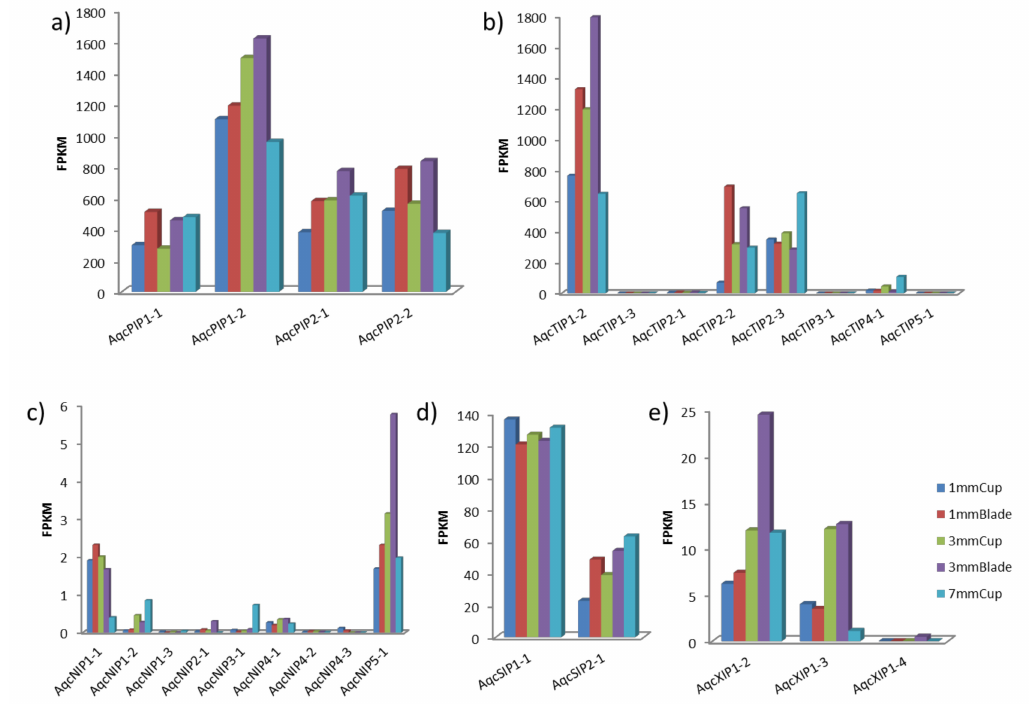
Figure 6. Expression of Aquilegia aquaporins using RNA-seq data. The normalized expression values in terms of fragments per kilobase of transcript per million mapped reads (FPKM) in ( a ) plasma membrane intrinsic proteins (PIP), ( b ), tonoplast intrinsic proteins (TIPs, ( c ) nodulin 26-like intrinsic proteins (NIPs), ( d ) small intrinsic proteins (SIPs), and ( e ) uncharacterized intrinsic proteins (XIPs)). Early developmental stages of Aquilegia ’s petal spur were studied in a 1-mm cup, a 3-mm cup, a 7-mm cup, a 1-mm blade, and a 3-mm blade of petal